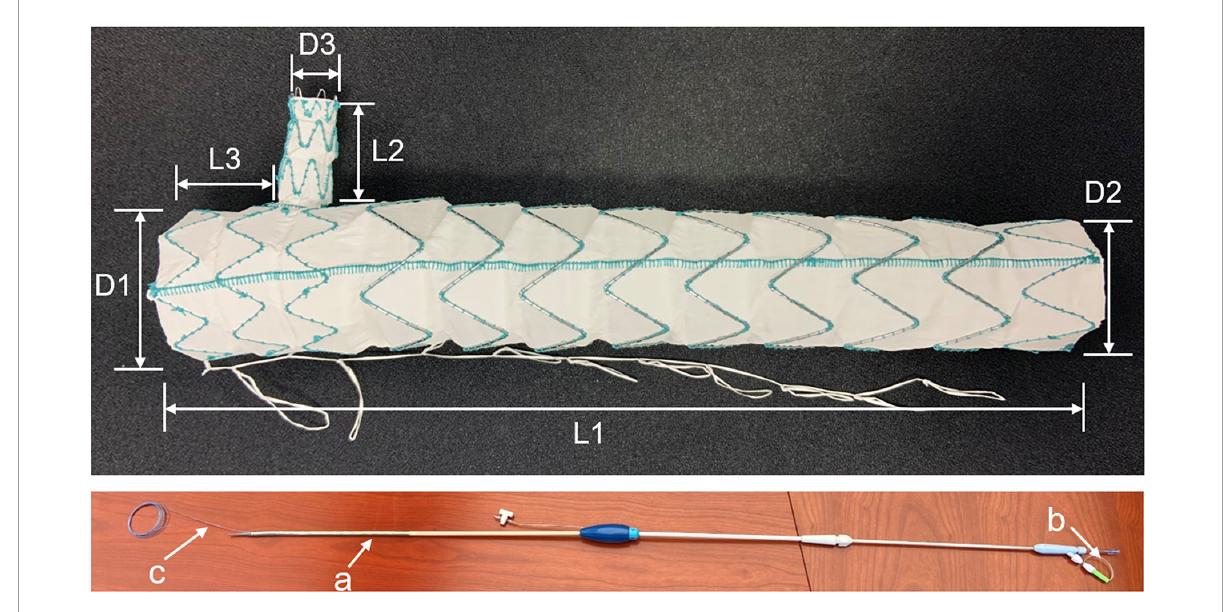
FIGURE1 Castor single-branched stent graft and the delivery system. a, 24-Fr outer sheath; b, trigger wire; c, traction wire.